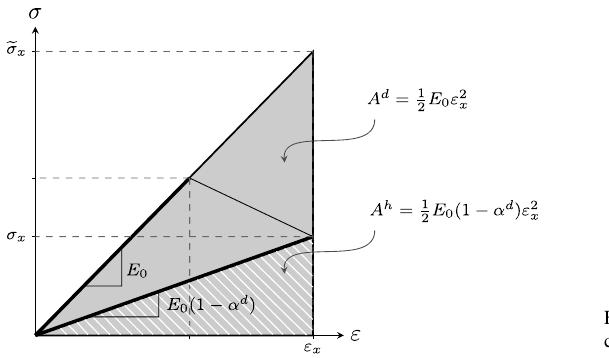
Fig. 1. Stress-strain diagram for the material at the stage of loss of stiffness.